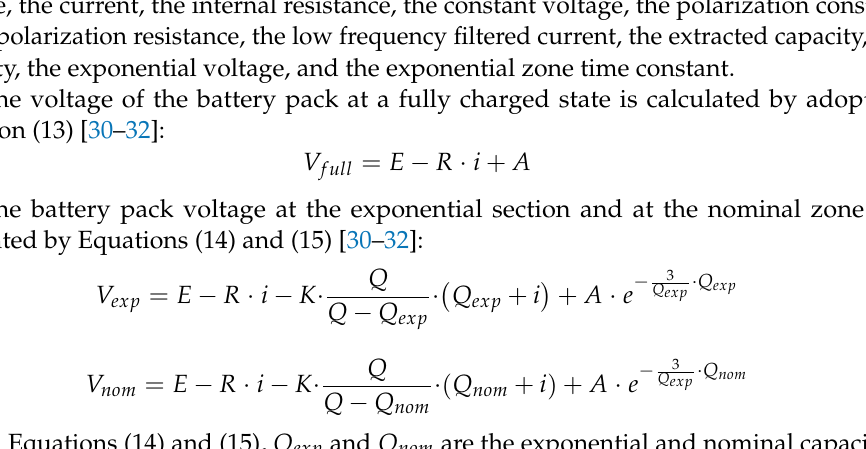
Figure 2. Comparison between the PEM stack theoretical polarization (blue line) and electric power (red line) curves and PEM stack experimental data supplied by the manufacturer.